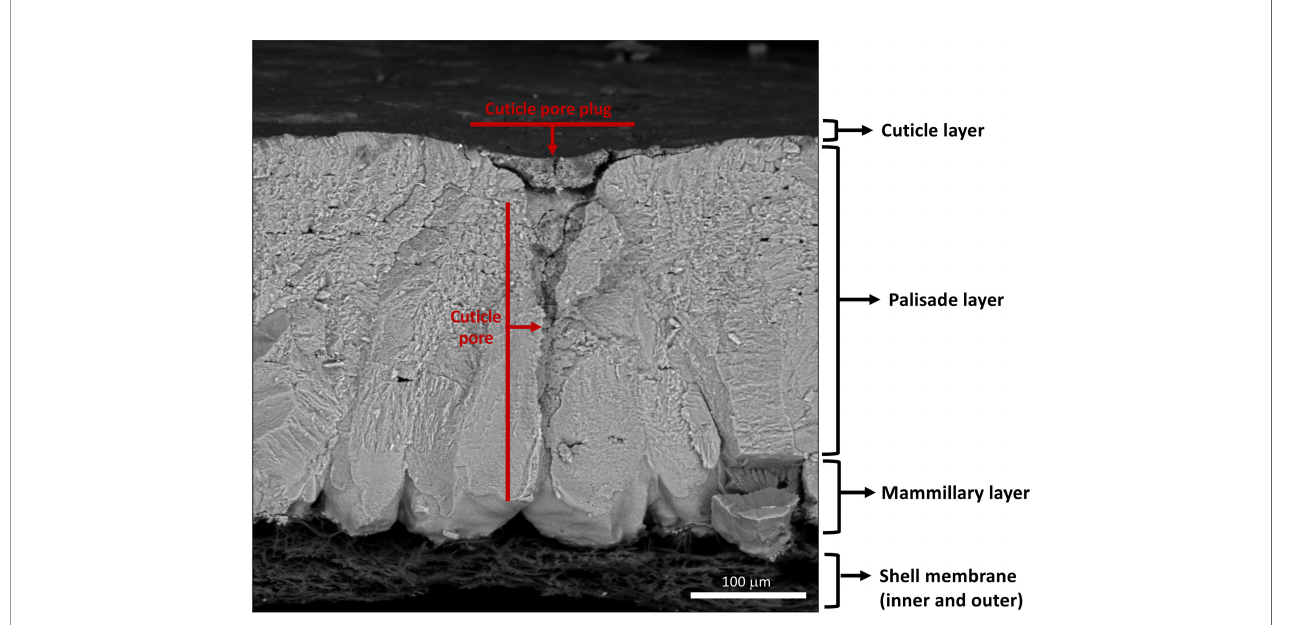
FIGURE 3 | Scanning electron micrograph of cross-fractured eggshell showing different layers: cuticle, palisade layer, mammillary layer with associated inner and outer shell membranes and full-length respiratory pore with pore plug. (Original image by